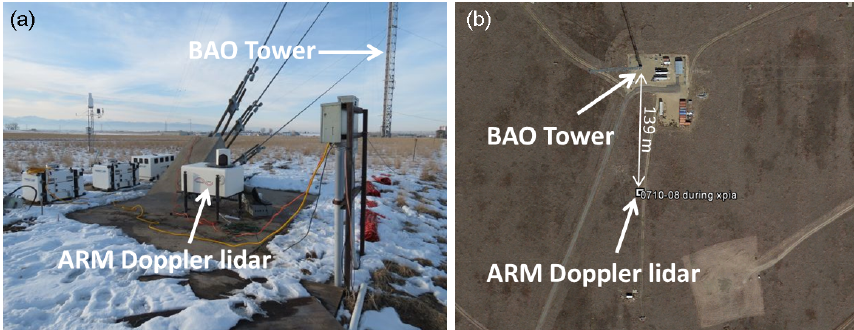
Figure 1. (a) Setup of the ARM Doppler lidar and (b) aerial view showing the location of the lidar relative to the BAO tower during